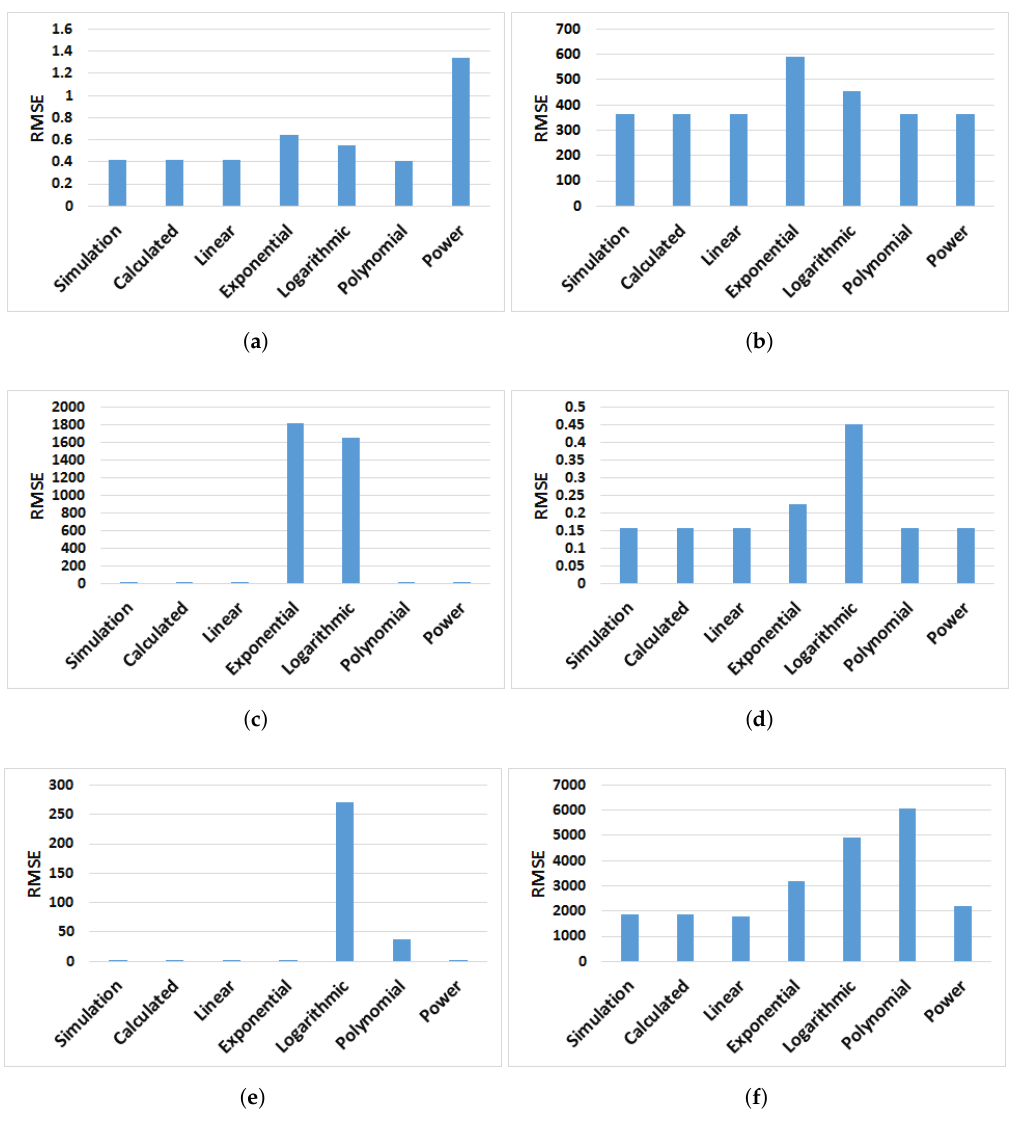
Figure A10. RMSE comparison between the results from simulation and analytically calculated values for steam (Area 1): ( a ) API; ( b ) depth; ( c ) permeability; ( d ) porosity; ( e ) saturation; and ( f )